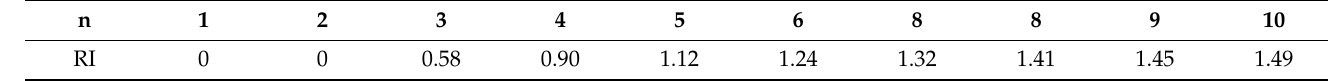
Table A2. Randomly generated values of consistency index ( RI